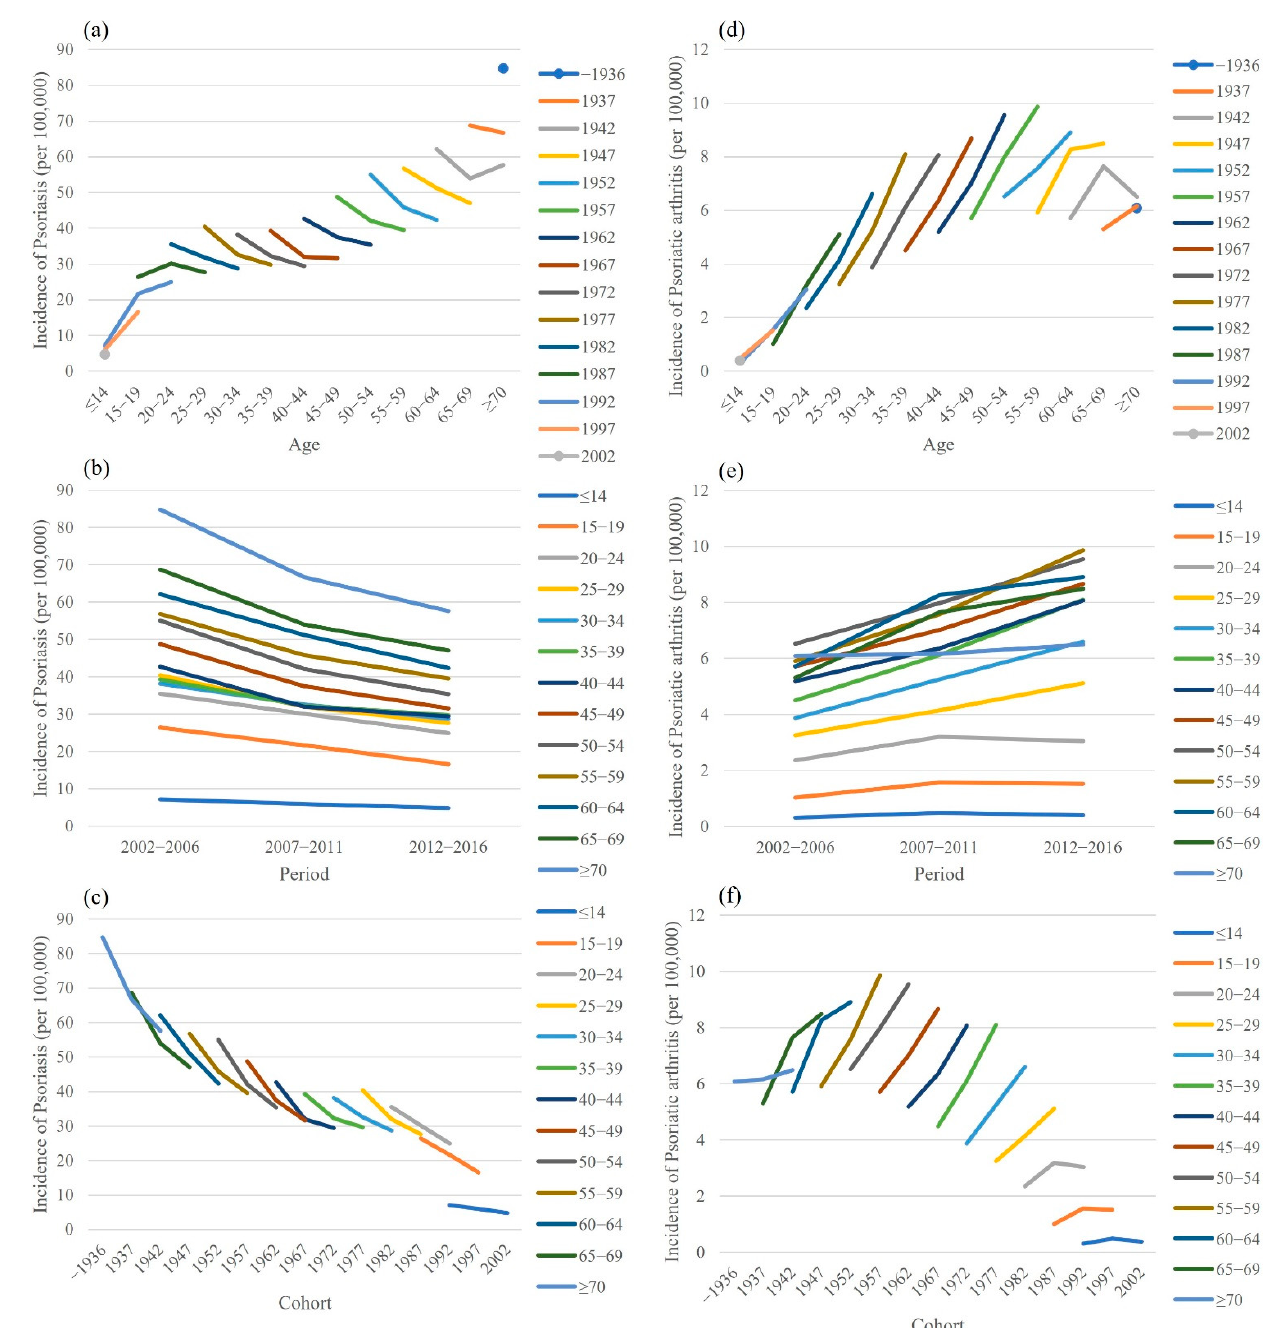
Figure 2. Incidence rates of psoriasis and psoriatic arthritis by age, period, and cohort. ( a ) age trends by cohort, ( b ) period trends by age, ( c ) cohort trends by age, ( d ) age trends by cohort, ( e ) period trends by age, and ( f ) cohort trends by